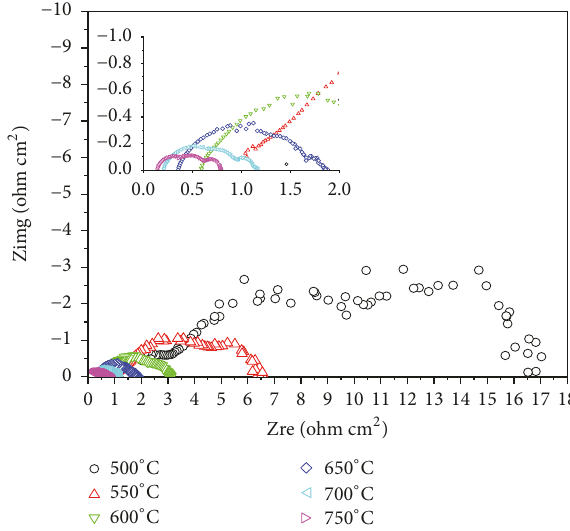
Figure 6: Voltage and power density curves versus current density at different temperatures.